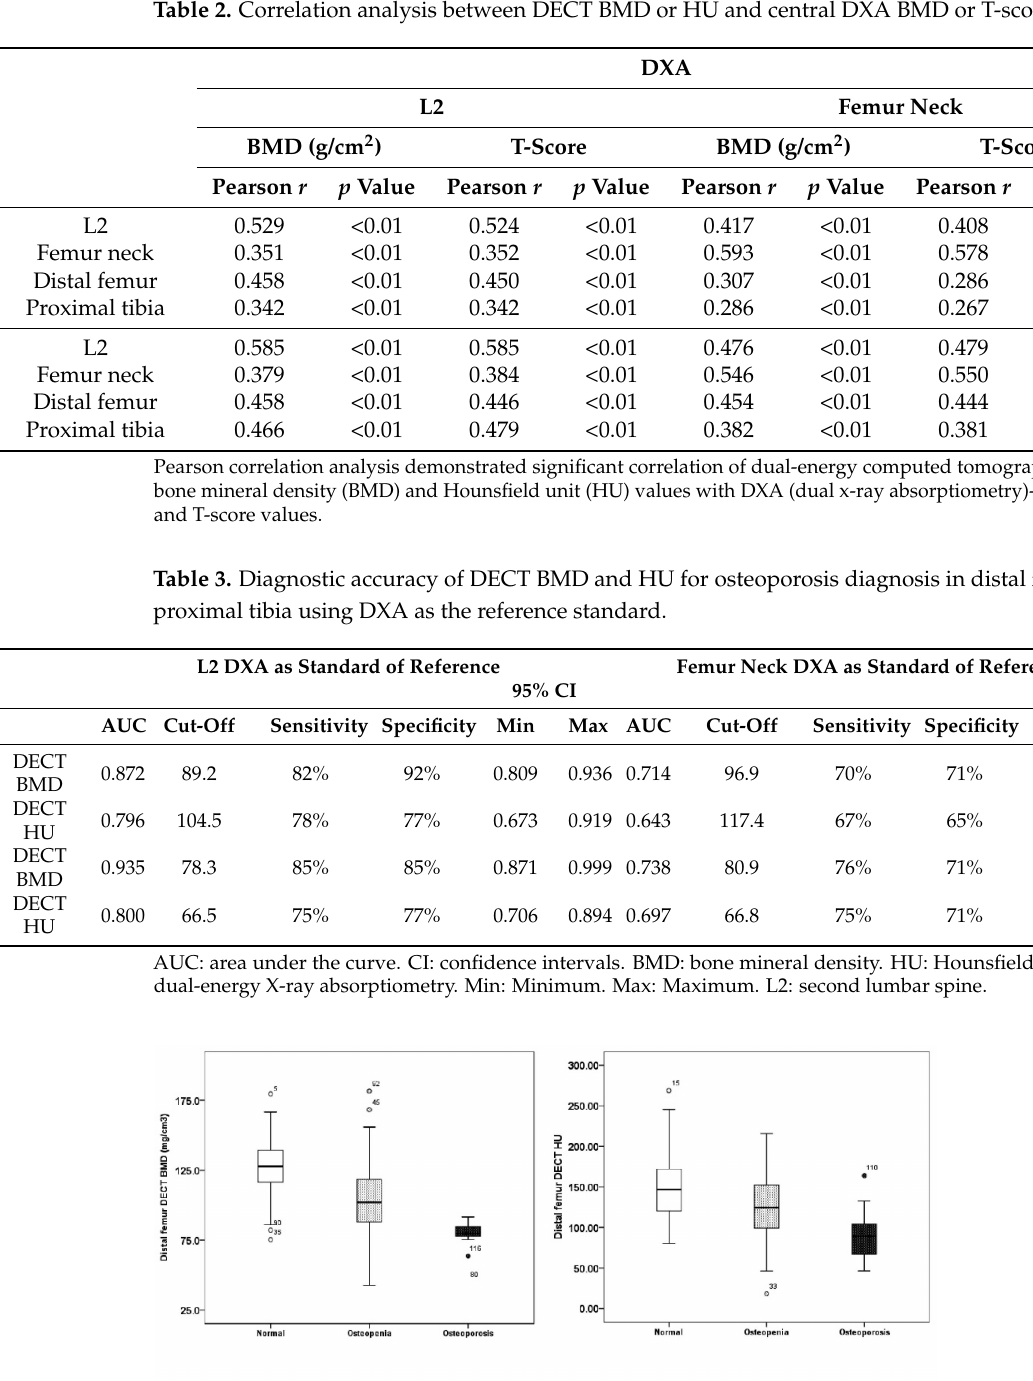
Table 2. Correlation analysis between DECT BMD or HU and central DXA BMD or T-score.